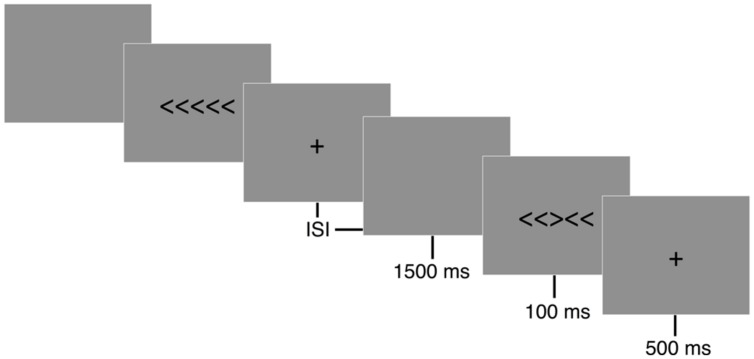
Eriksen flanker task. Following a 500 ms fixation cross (+), either congruent (< < < < <) or incongruent (< < > < <) stimuli were displayed focally for 100 ms on a computer screen. Participants were instructed to respond to the direction of a centrally positioned target arrow as quickly and accurately as possible. A button press corresponding to the direction of the centrally positioned arrow was recorded during a 1500 ms response window. A random inter-stimulus interval (ISI) of 1100, 1300, or 1500 ms occurred following the participant’s response to reduce expectancy effects.